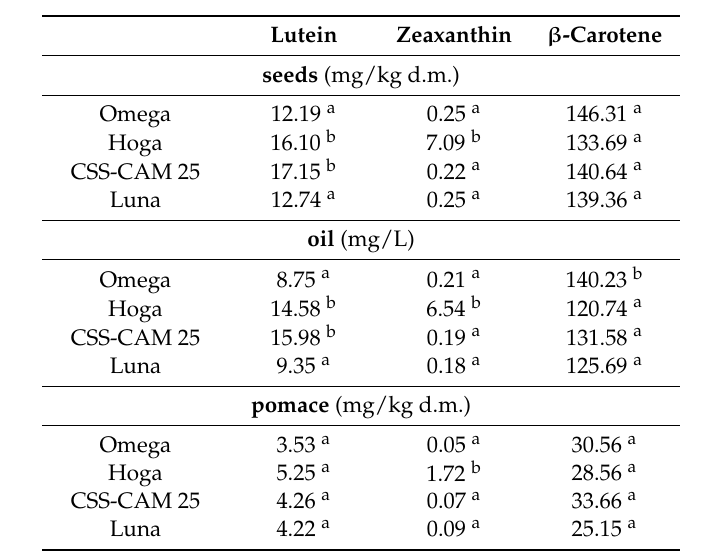
Table 3. The content of β -carotene, zeaxanthin, and lutein in oil, pomace, and seeds of spring and winter genotypes of Camelina sativa